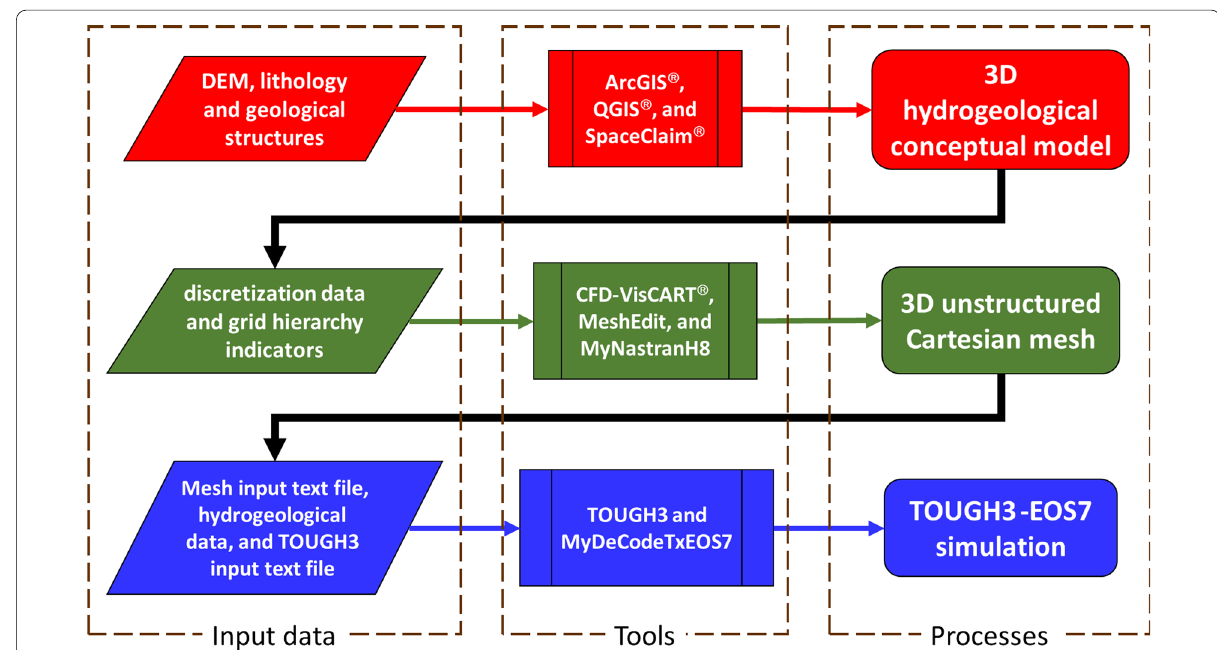
Fig. 1 The trilogy workflow developed in this paper for numerical simulations of groundwater flow. Three main processes in the rightmost column formed the trilogy core, and the input data and tools needed for each process are identified in the left and middle blocks in a row. Starting from the upper left block and following the workflow direction leads to the final step of a TOUGH3‑EOS7